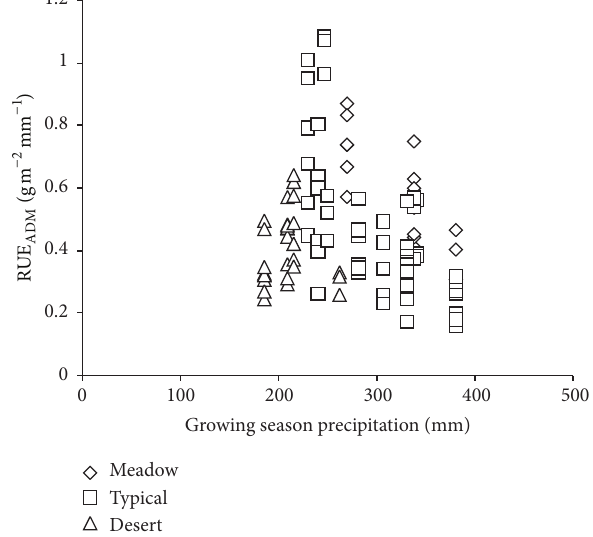
Figure 4: Relationship of RUE ADM (gm −2 mm −1 ) with growing season precipitation (mm) in meadow steppe, typical steppe, and desertsteppeacrossthegrasslandofInnerMongolia.RUE ADM =rain use efficiency based on above ground dry matter.